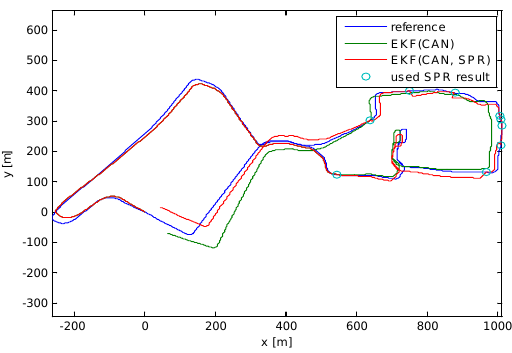
Figure 13. The comparison of the estimated trajectory Figure 14 shows the distance differences comparing to the reference data. The red line means the comparison results of the in-vehicle sensor only method and the blue dashed line does the comparison result from the sensor fusion method. Table 15 indicates the error statistics comparing with the reference data. The RMSE of the in-vehicle sensor only method and the proposed sensor fusion method are 21.4 m and 15.4 m respectively. This figure and table show the proposed estimation method is effective to reduce errors although we use only 9 SPR results.